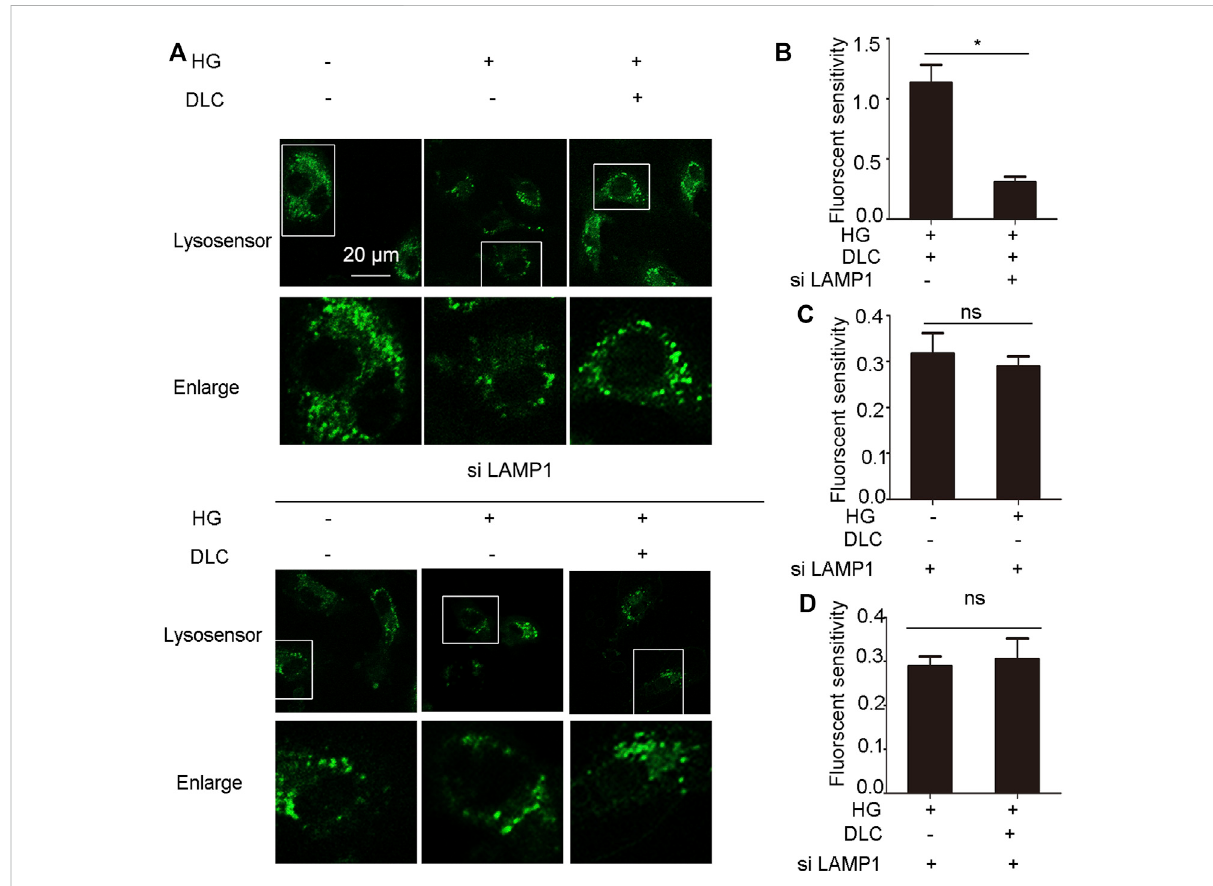
FIGURE 8 LAMP1 affected the proton channel of V-ATPase. (A – D) : HUVECs transmitted LAMP1 SiRNA (40 nM) 24 h, then cells were treated with DLC (1 μ M) under HG condition for 24 h, H + levels in lysosomes were detected by Lysosensor ™ Green DND-189. Scale bar: 20 μ m, * p < 0.05, n =